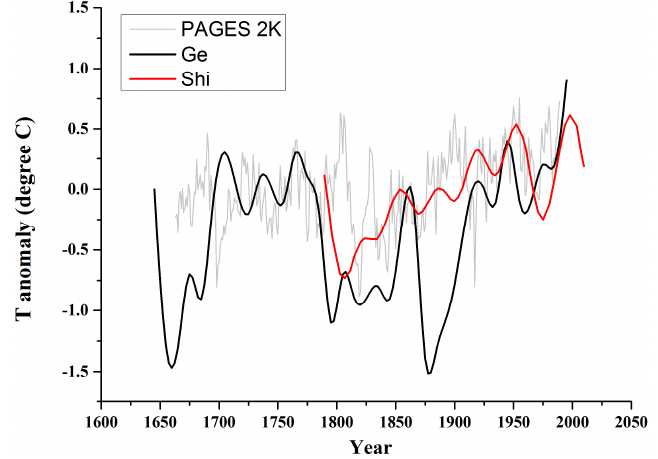
Figure 3. Temperature anomaly reconstructions: PAGES 2K representing Asian temperature [35]; Ge representing central and eastern China winter half-year temperatures based on historical archives [36]; Shi representing southeastern Tibetan Plateau summer minimum temperature [37].